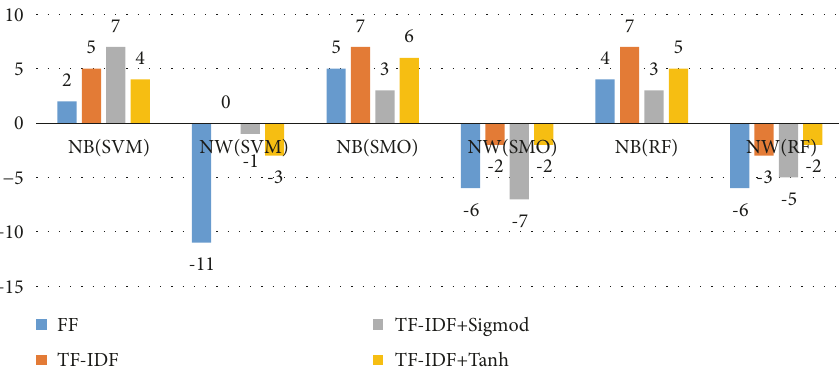
Figure 5: Best and worst number of activity concerning on accuracy concerning on “cario”.